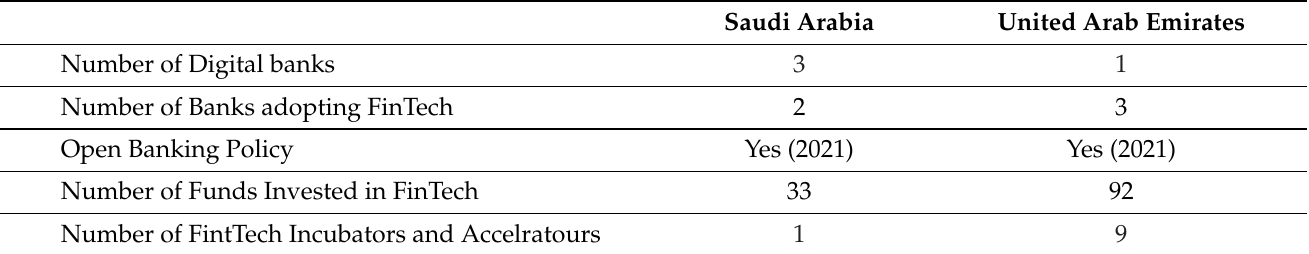
Table 3. A comparison of financial institutions in Saudi Arabia and the United Arab Emirates (Source: Crunch Base).